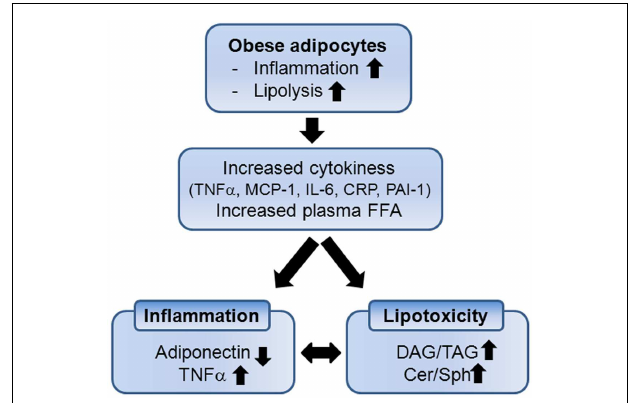
FIGURE 1 | Enlarged adipocytes by obesity contribute to systemic inflammation and lipotoxicity due to increased cytokines and accumulation of lipid metabolites in non-adipocyte tissues. DAG, diacylglycerol;TAG, triacylglycerol; Cer, ceramide; Sph,